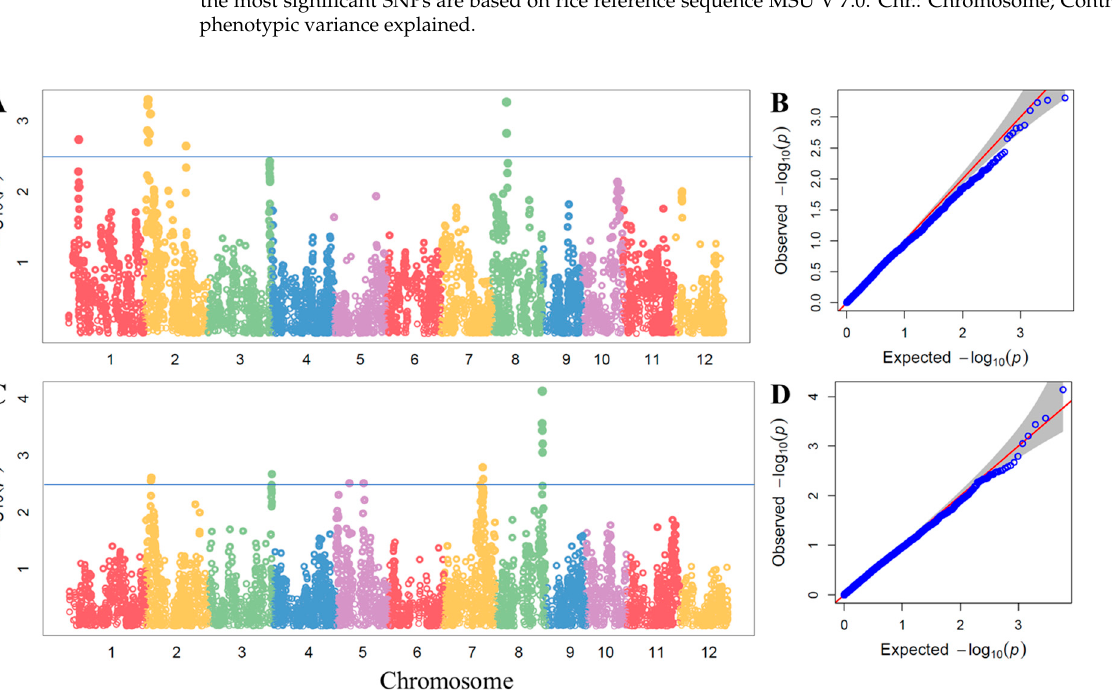
(Table 1, Figure 3). Based on annotation